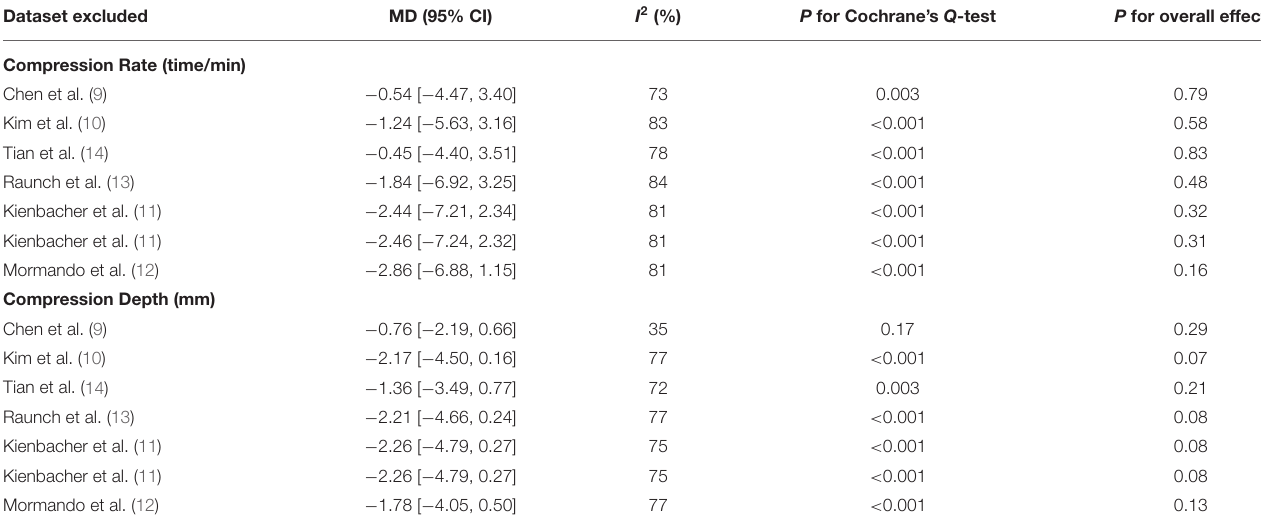
TABLE 3 | Sensitivity